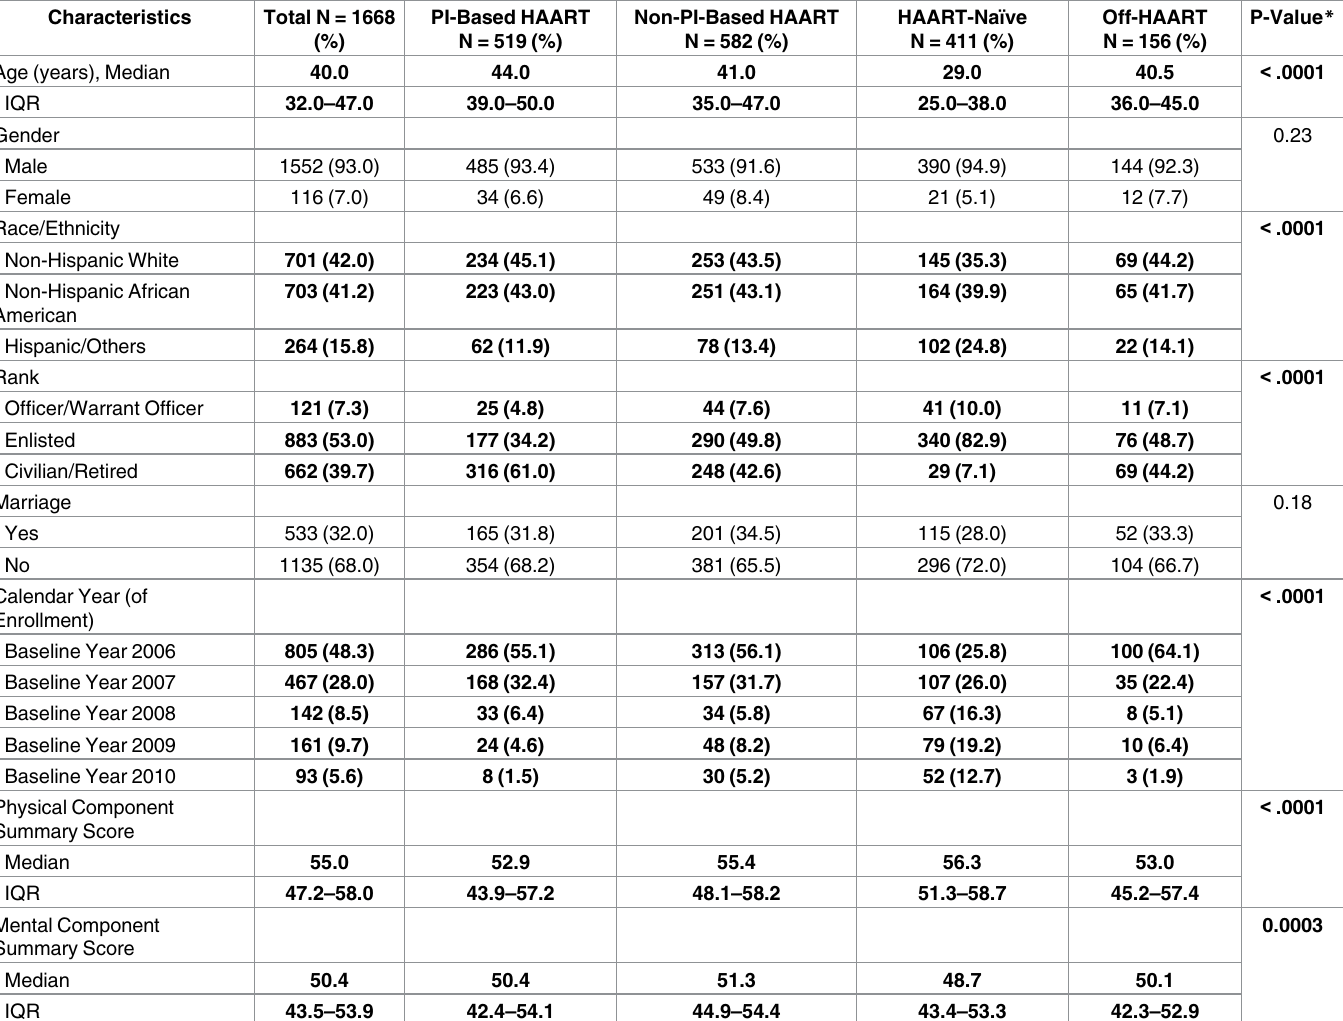
Table 1. Baseline demographic/background